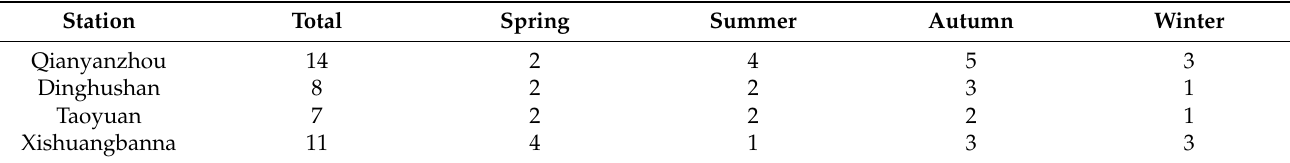
Table A1. The number of available Landsat 8 images used to calculate the thermal heterogeneity at four flux sites. Station